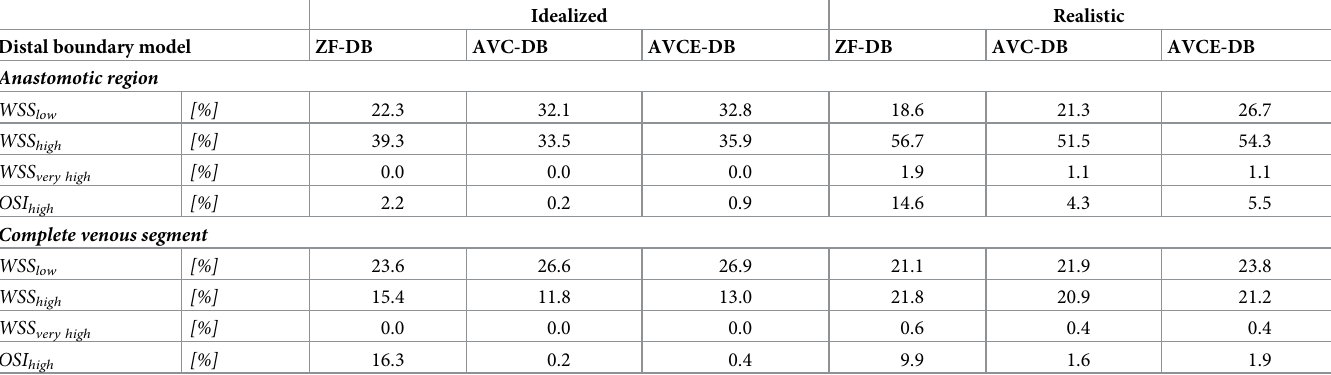
Table 1. Overview of the metrics for disturbed hemodynamics in the anastomotic region and over the complete venous segment.